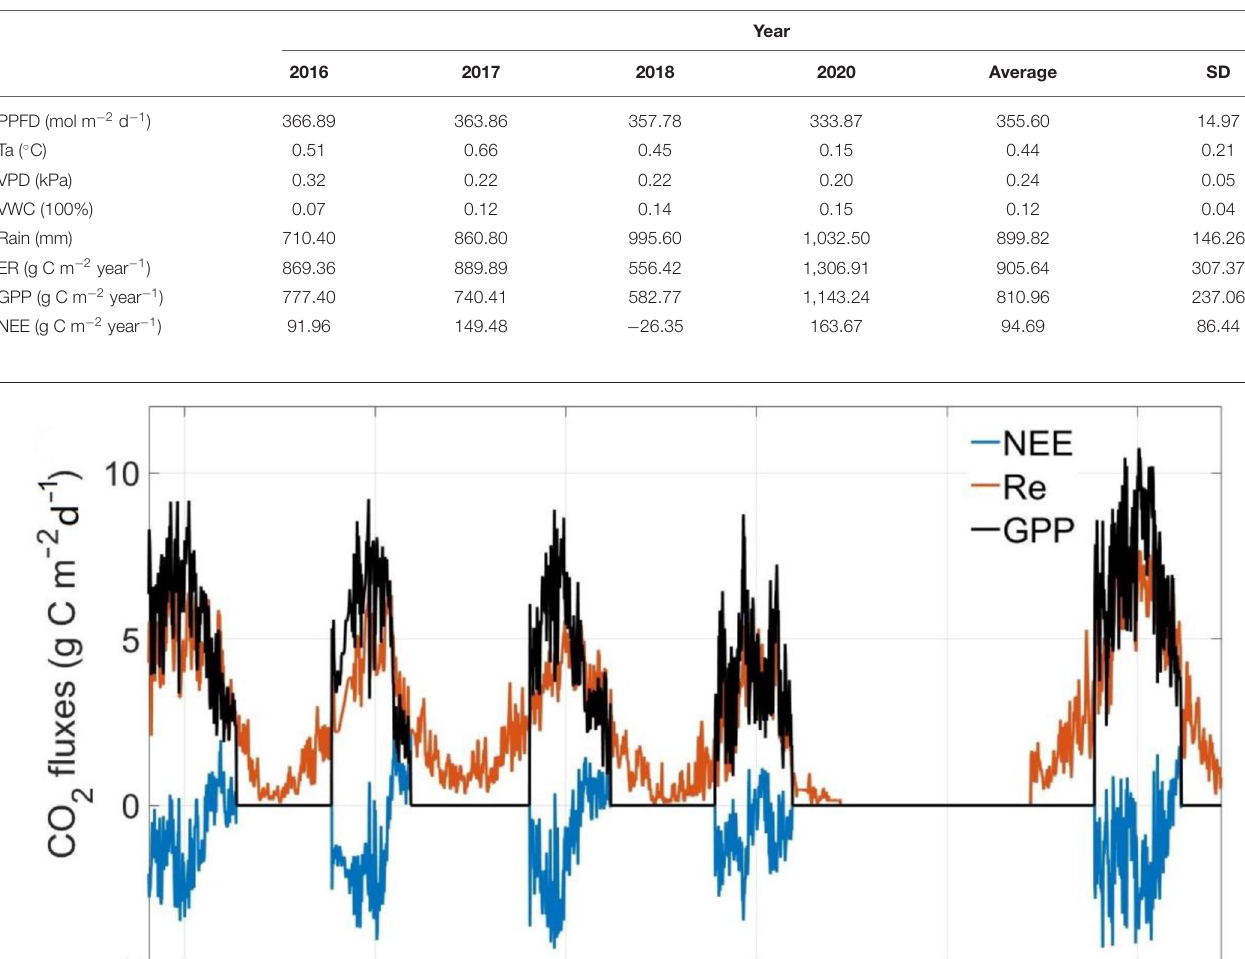
TABLE 1 | Climatic factors and carbon fluxes for 2016–2018 and 2020.